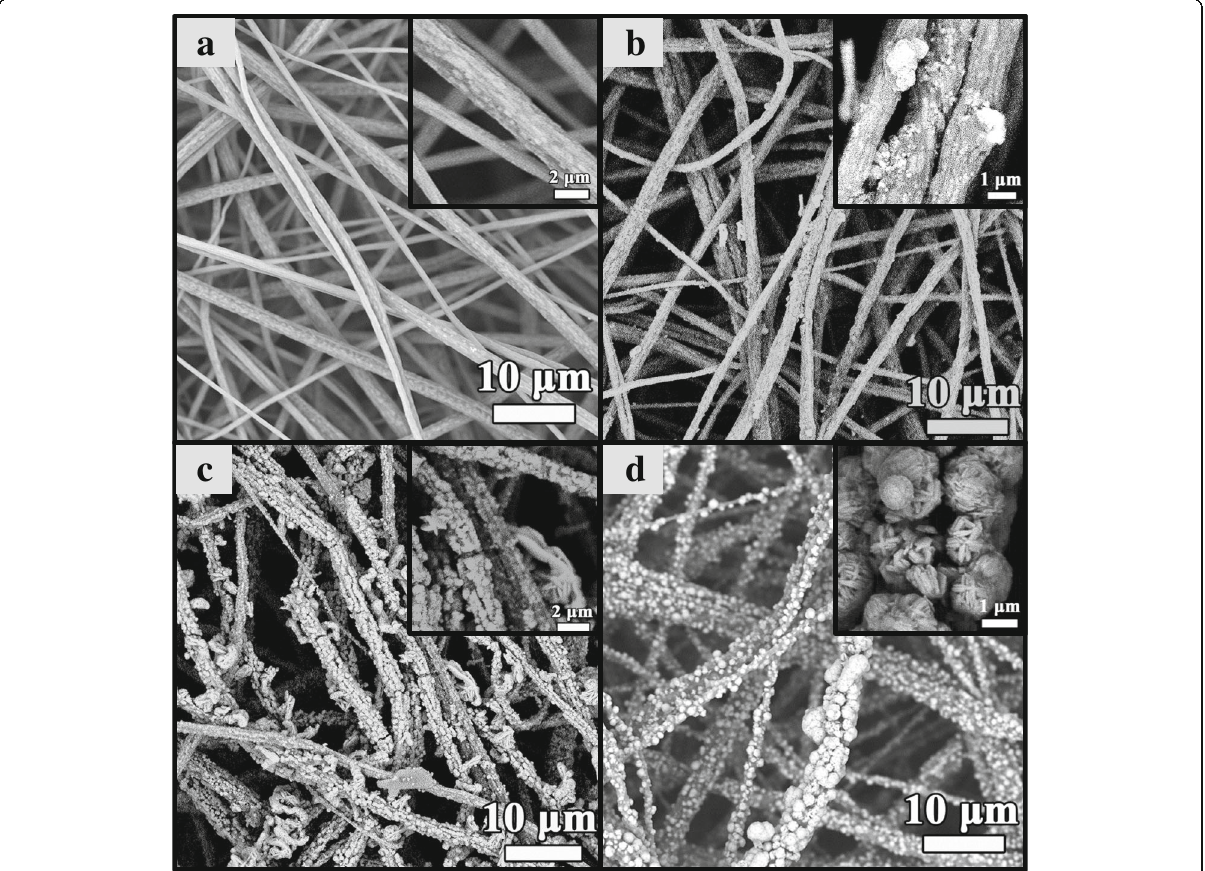
Fig. 2 SEM images of a TiO 2 /PVDF fibers, b Cu 0.1, c Cu 0.5, and d Cu